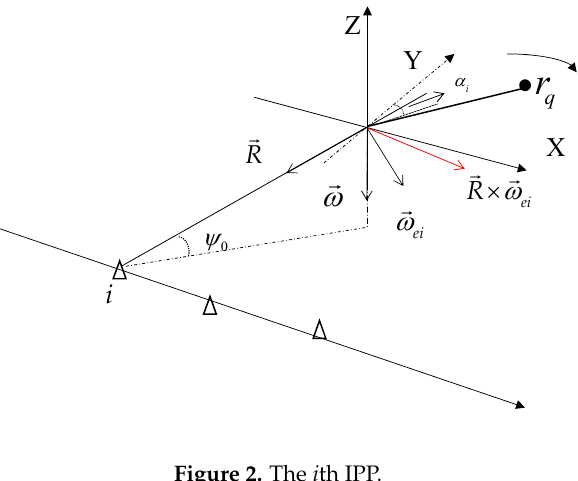
Figure 2. The i th